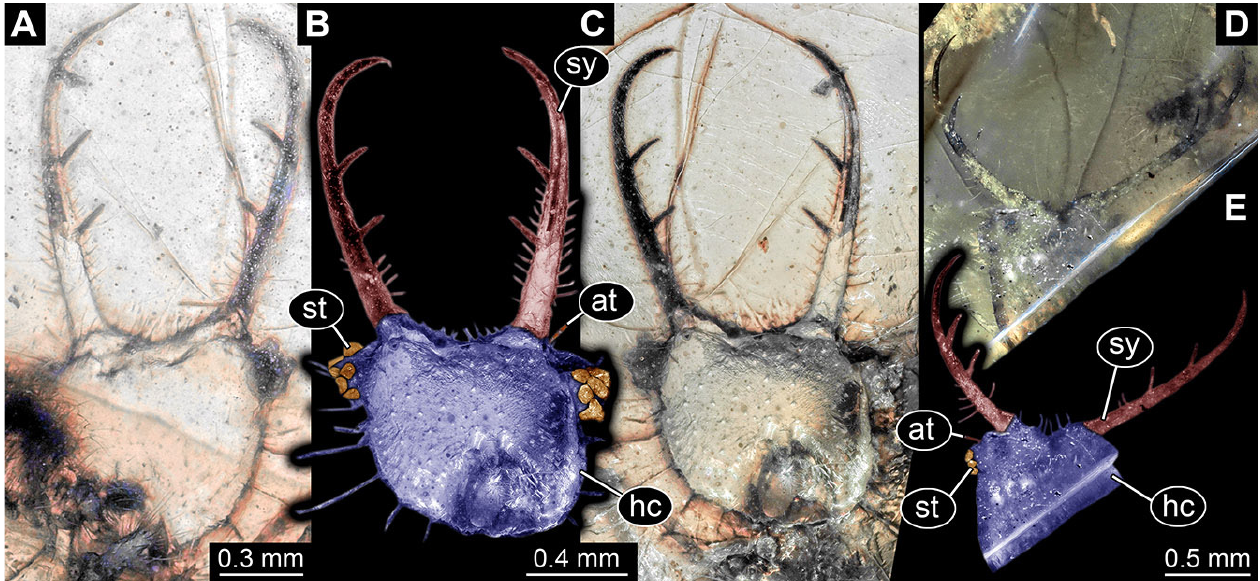
Figure 18. Fossil owllion larvae, Cretaceous Kachin amber, Myanmar. ( A – C ) Specimen 3231 (PED 0083e). ( A ) Overview, ventral. ( B ) Color-marked version of ( C ). ( C ) Overview, dorsal. ( D , E ) In- complete specimen (PED 0083f). ( D ) Overview. ( E ) Color-marked version of ( D ) Abbreviations: at = antenna; hc = head capsule; st = stemmata; sy = stylet.